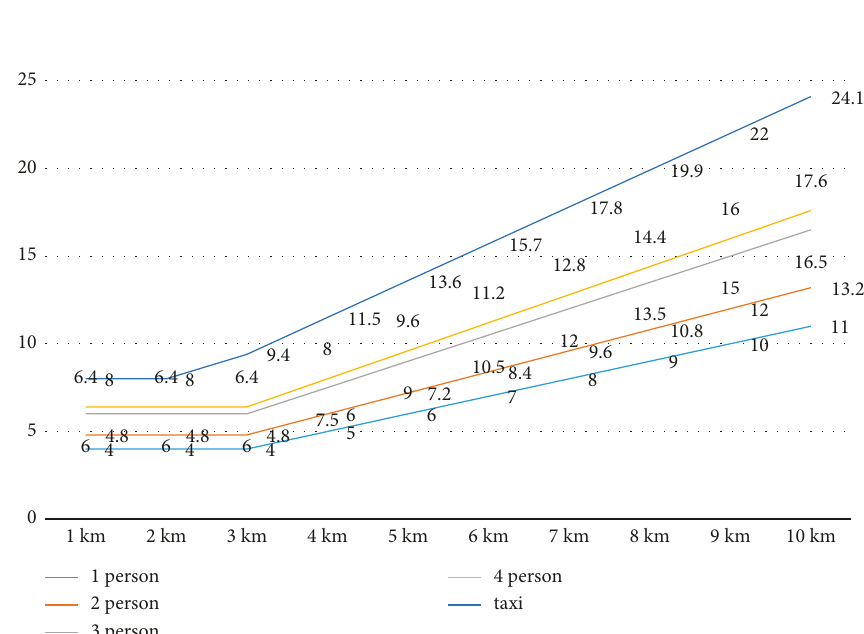
Figure 13: Price comparison of different mileage between bus sharing and